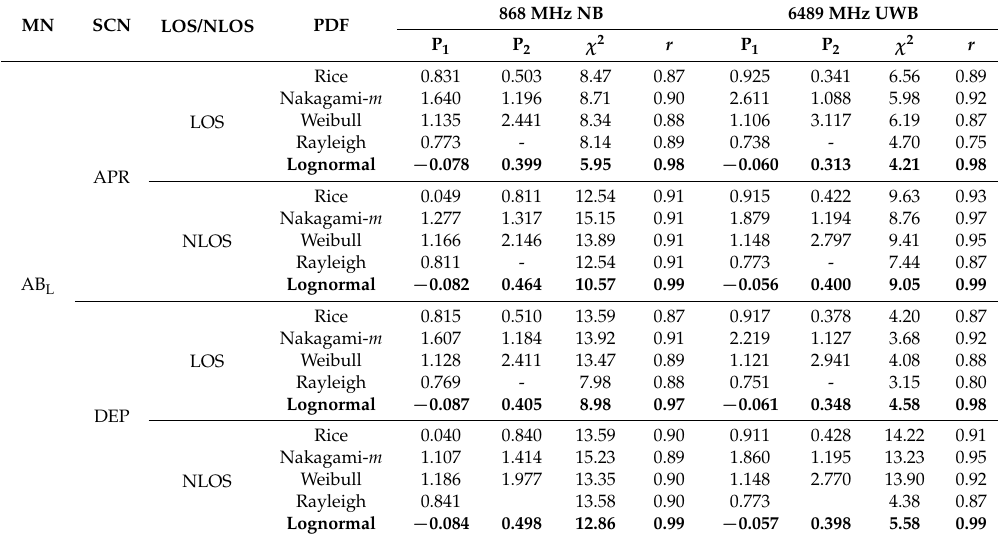
Table 5. The parameters of PDFs fitted to empirical distributions of small-scale fading amplitudes for AB L